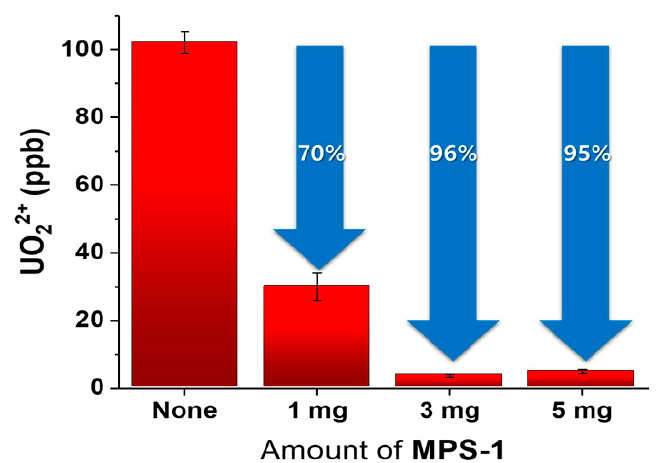
22 + adsorption of MPS-1 in 100 ppb UO 22 + Figure 5. Result of UO 22+ adsorption of MPS-1 in 100 ppb UO 22+ solution. Figure 5. Result of UO